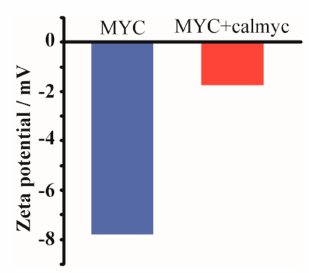
Figure 8. Zeta potentials of MYC incubated with Ca 2+ for 3 h with or without